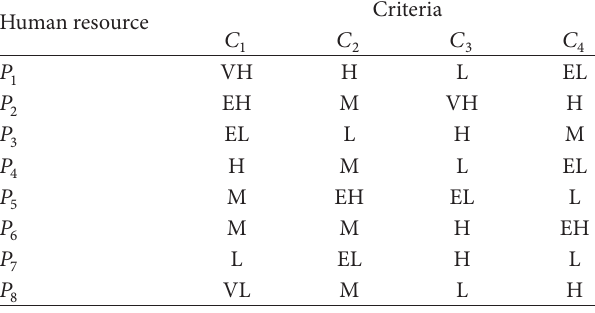
Table 3: Fuzzy multicriteria decision matrix.